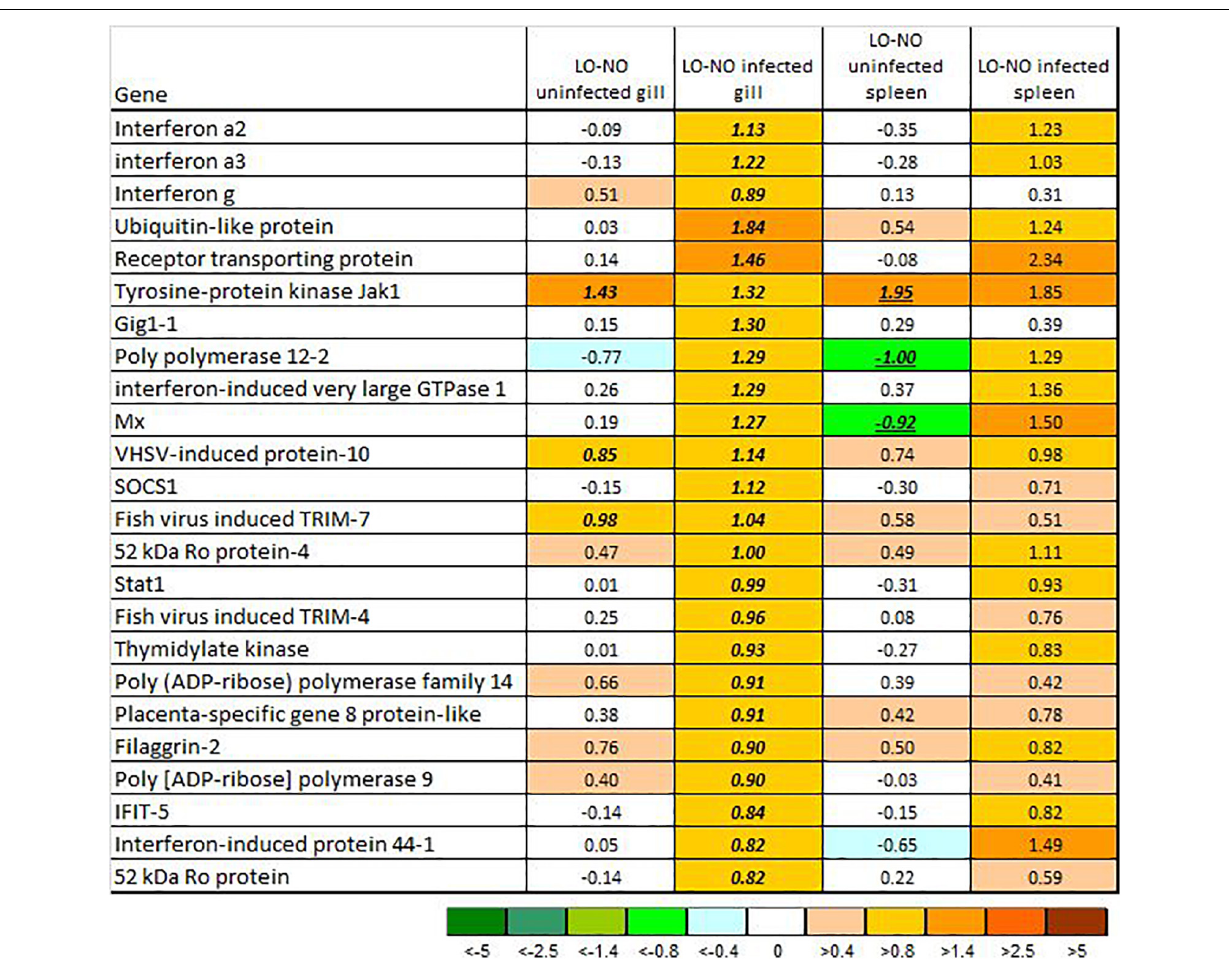
FIGURE 7 | Expression of genes involved in innate antiviral responses (VRG). Data are log 2 -ER (LO to NO expression ratios). Significant differences are indicated with underlined italics. NO, LO – groups maintained at normal and low dissolved